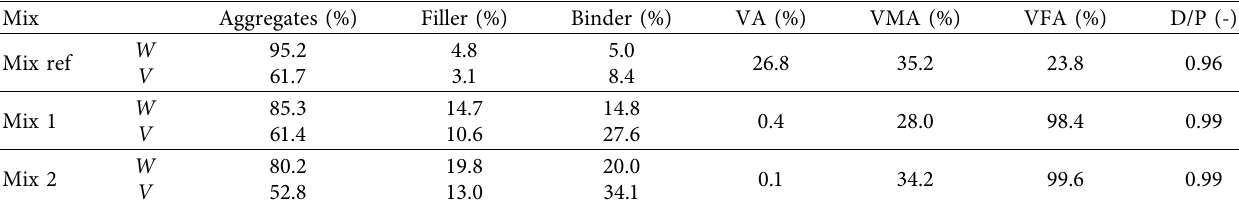
Table 2: Volumetric properties at maximum gyration numbers (by weight ( W ) and by volume ( V ) for mix 1 and mix 2 (EN 12697—parts 5, 6, and